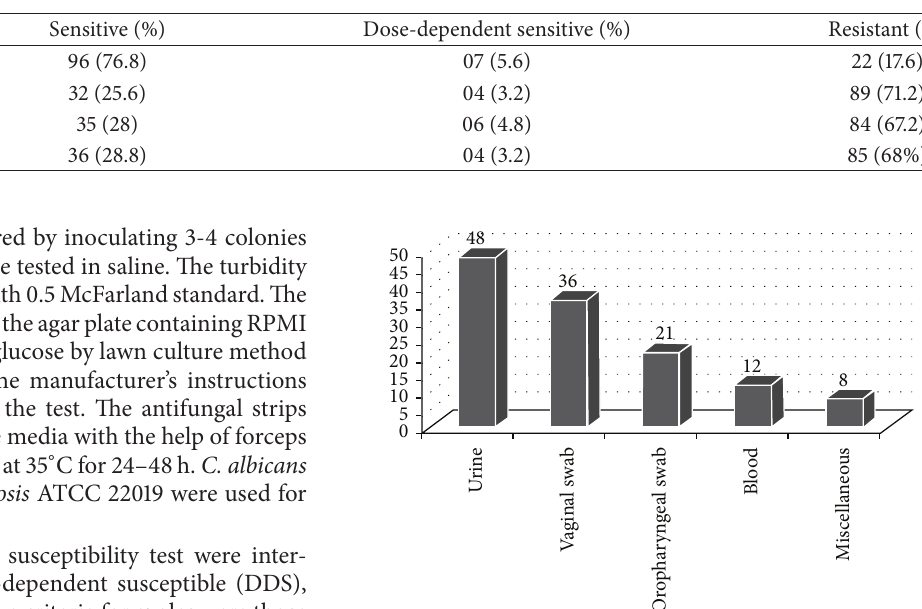
Table 2: Antifungal susceptibility profile of Candida tropicalis .